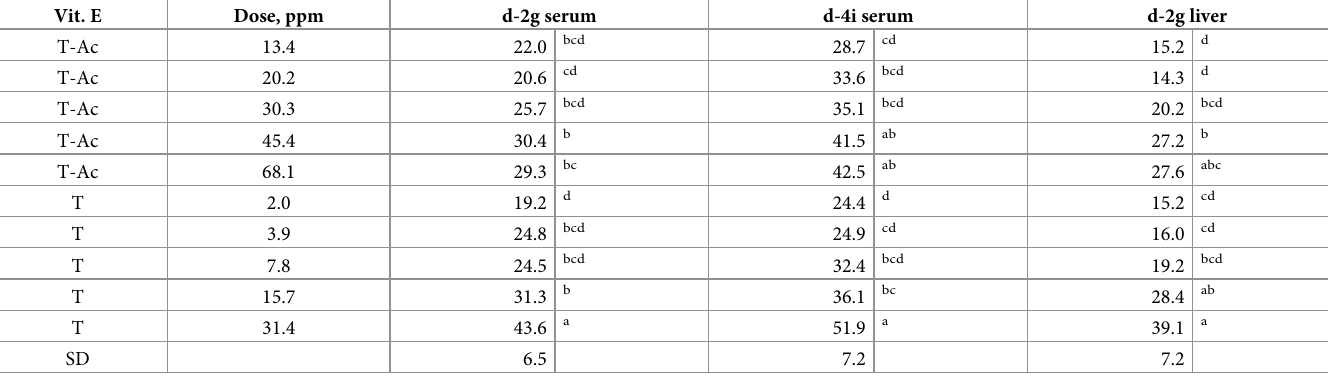
Table 5. Serum ( μ M) and liver ( μ g/g) vitamin E levels analyzed using traditional analysis of variance using a Tukey comparison (T-Ac = tocopheryl-acetate, T = tocopherol). Vit.